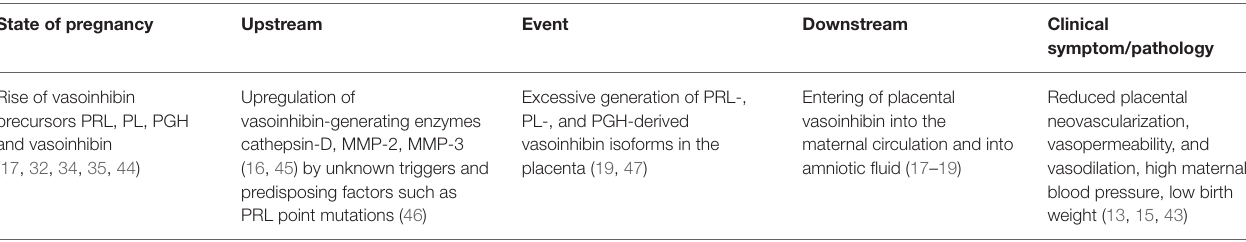
TABLE 2 | Proposed mechanistic pathways involved in preeclampsia.